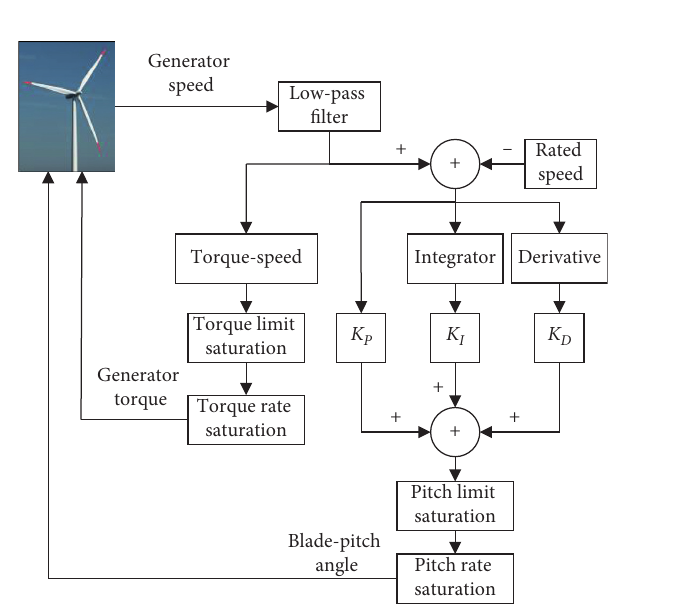
Figure 2: The schematic representation of